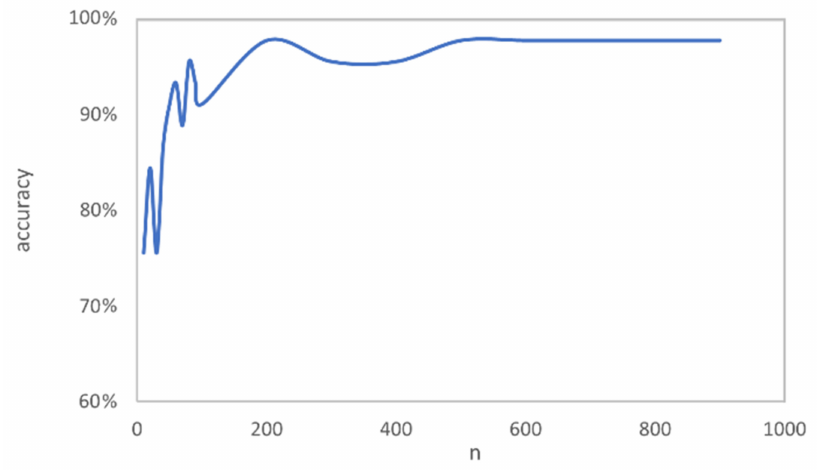
Figure 7. The accuracy changing tendency of the overall classification accuracy corresponding to the increase in n